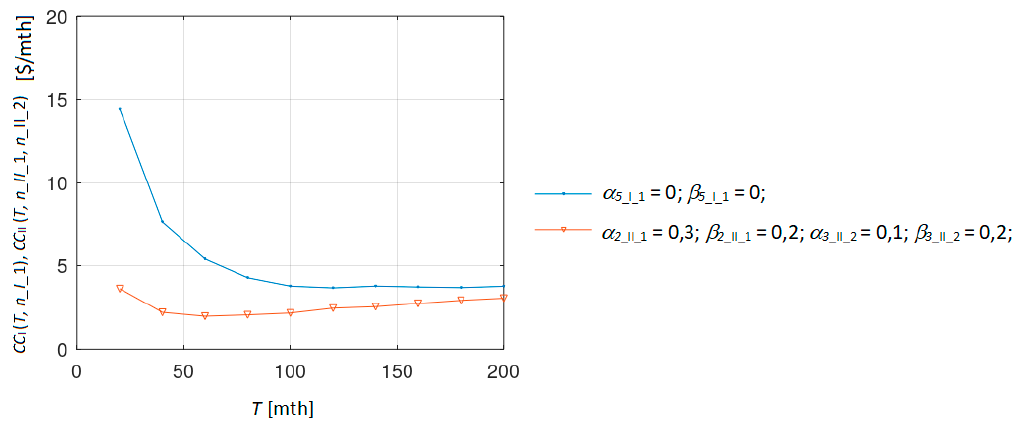
Figure 4. The lowest expected cost per unit time found for the tested one-stage and the two-stage policies.